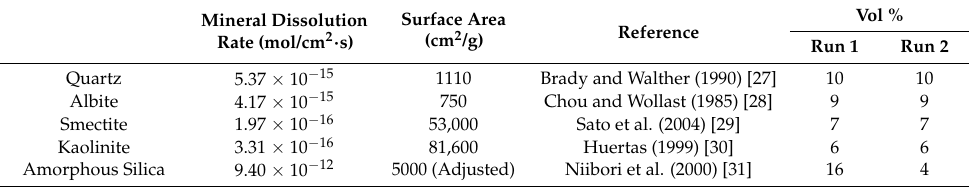
Table 2. Mineral dissolution rates and surface areas of silica-bearing phases loaded in the geochemical modeling as